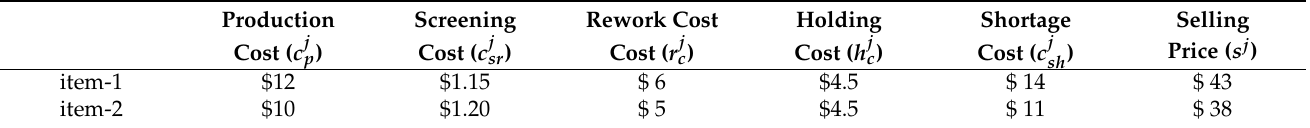
Table 2. Input data for the cost